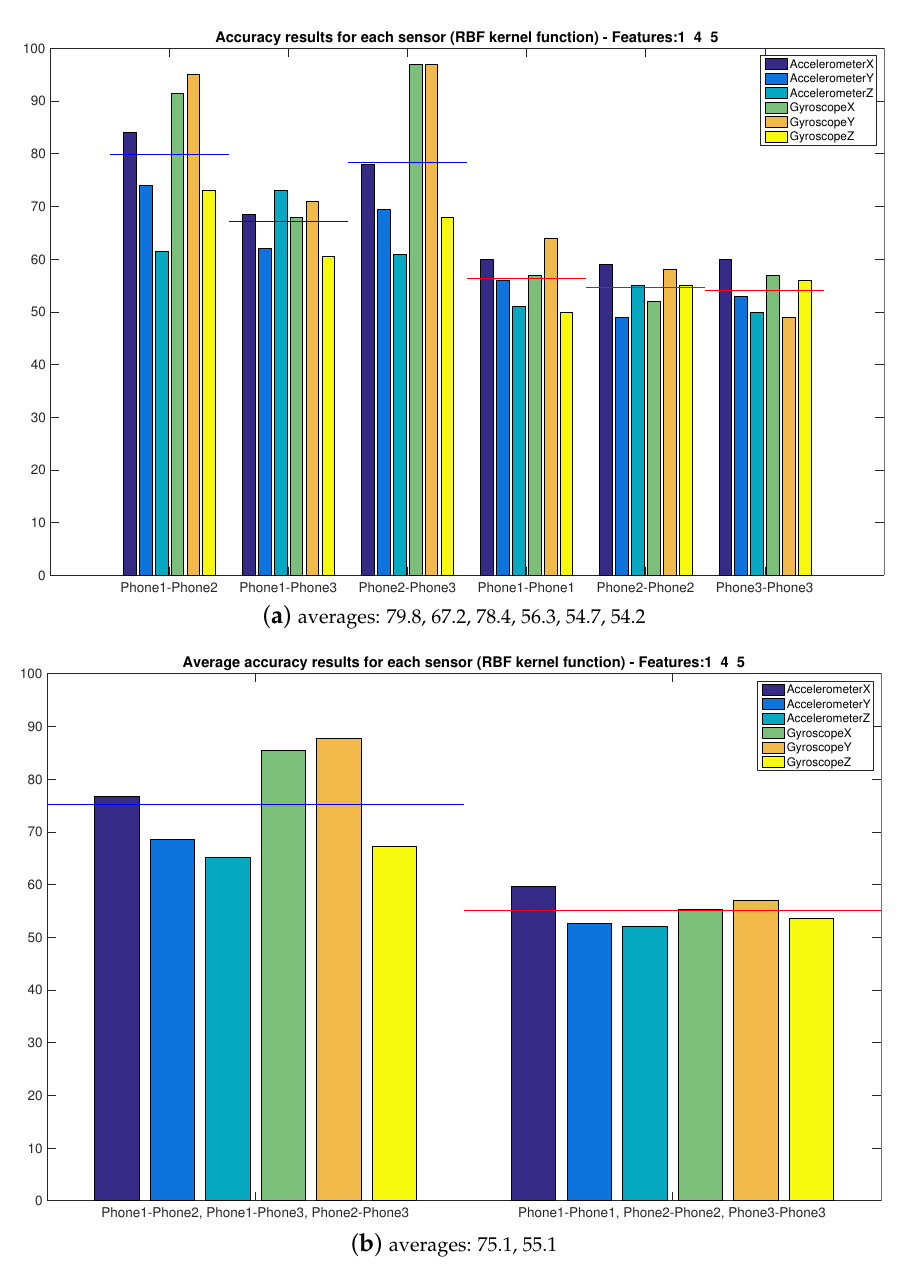
Figure 8. Accuracy for features one, four and five for all of the Microelectromechanical (MEMS) components. Table 1. Optimum values of the threshold parameter for the Entropy statistical features for each axis of the Accelerometer and